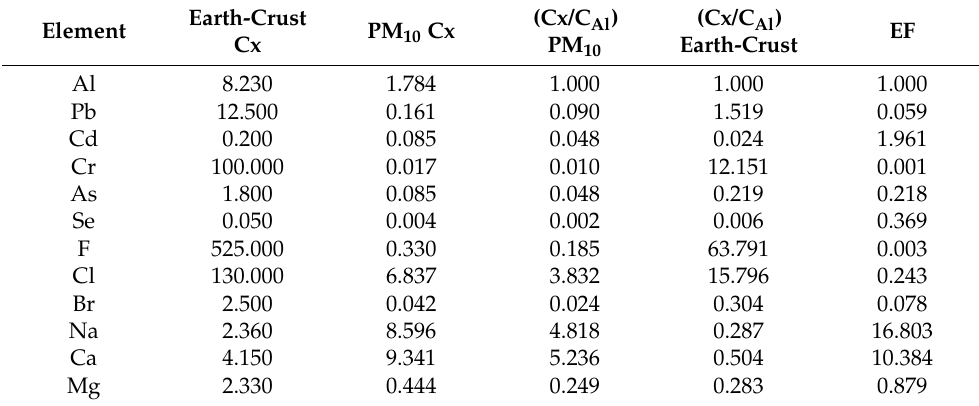
Table 1. Enrichment factors (EF) of various chemical